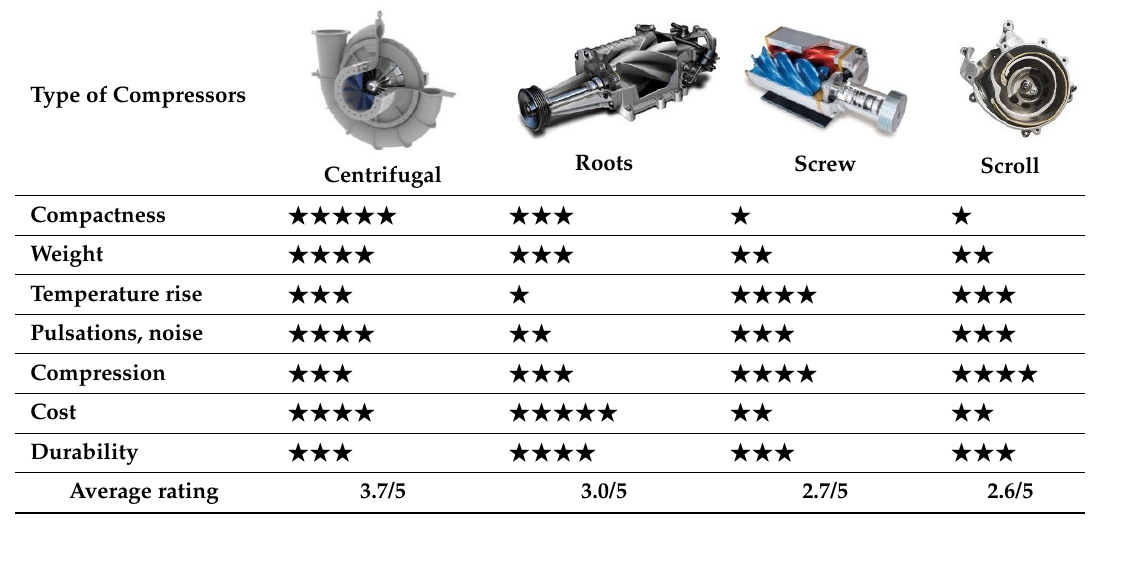
Table 2. Comparison of centrifugal, roots, screw, and scroll compressors [24–28].